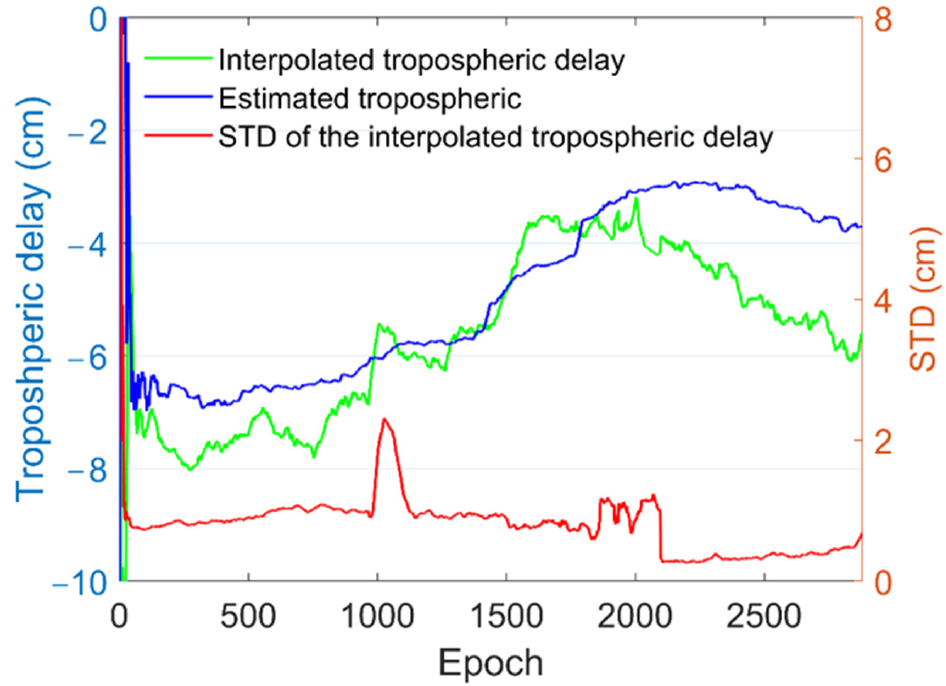
Figure 3. Interpolated and estimated tropospheric delay and STD of the interpolated tropospheric delay of user station NCWA.